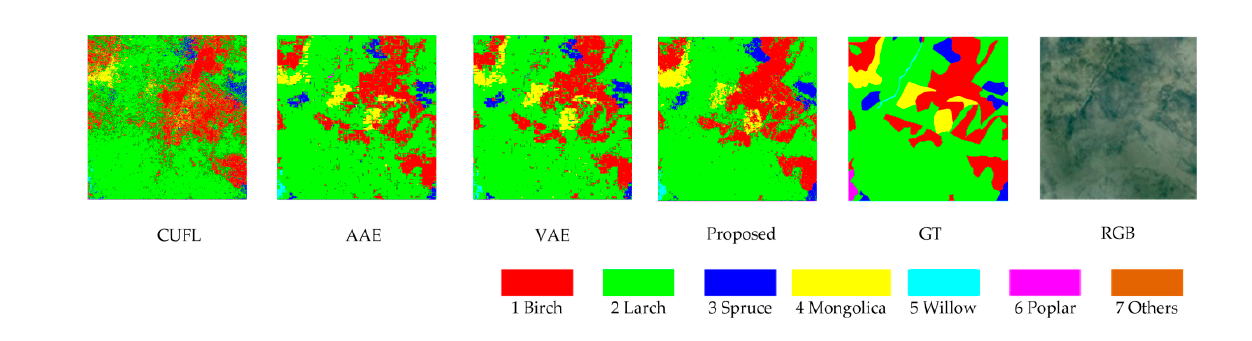
Figure 7. Tree classification maps of models for dataset (2). Table 13. The classification accuracy of models for dataset (3).